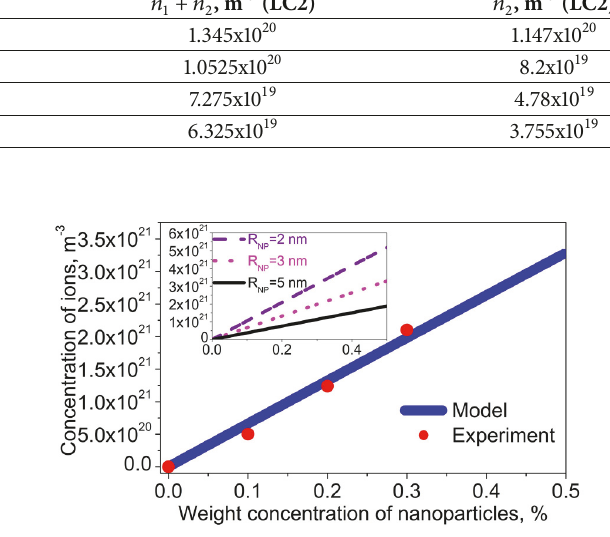
Figure 4: The concentration of “slow” ions in liquid crystals doped Figure 3: The concentration of ions in liquid crystals doped with with CdSe/ZnS quantum dots as a function of the weight concentra- TiO 2 nanoparticles as a function of the weight concentration of tion of nanodopants. The presented model (solid curve) is in good nanodopants. The presented model (solid curve) is in good agree- agreement with reported experimental data points (circles) (Table 2 ment with reported experimental data points (circles) [34]. Physical of paper [35]). An inset shows the same dependence calculated parameters used in simulations: 𝜎 𝑁𝑃 𝑆 = 2 × 10 18 𝑚 −2 , 𝐾 𝑁𝑃 = 3.65 × 10 −24 𝑚 3 , 𝑛 = 1.147 × 10 20 𝑚 −3 , ] = 0 , 𝑅 = 25𝑛𝑚 , and at different sizes of quantum dots. Physical parameters used in 0 𝑁𝑃 𝑁𝑃 𝜌 /𝜌 = 3.9 . simulations: 𝜎 𝑁𝑃 𝑆 = 10 18 𝑚 −2 , 𝐾 𝑁𝑃 = 10 −26 𝑚 3 , 𝑛 0 = 0𝑚 −3 , ] 𝑁𝑃 = 𝑁𝑃 𝐿𝐶 3.379 × 10 −3 , 𝑅 = 3𝑛𝑚 , and 𝜌 /𝜌 = 5.091 𝑁𝑃 𝑁𝑃 𝐿𝐶